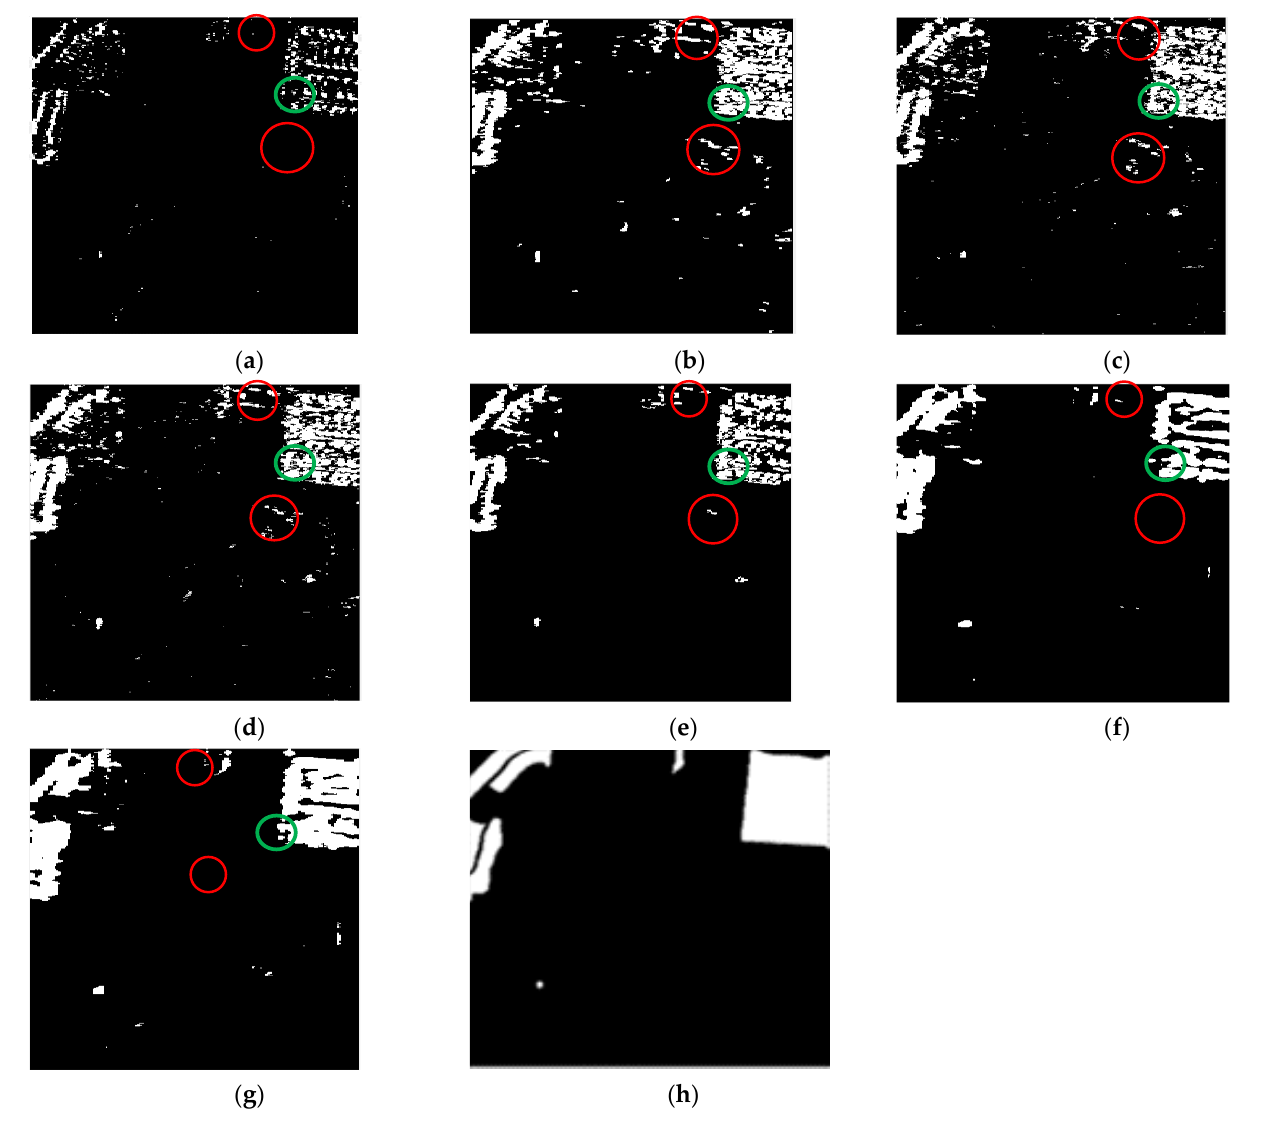
Figure 8. Visualized results of various CD methods on dataset#2; ( a ) PCA_kmeans, ( b ) NR_ELM, ( c ) Gabor_PCANet, ( d ) DP_PCANet, ( e ) CWNN, ( f ) dual-channel deep network, ( g ) TCD-Net and ( h ) ground truth. The red circles highlight different output performances in no-change pixels. The green circles highlight different output performances in change pixels.